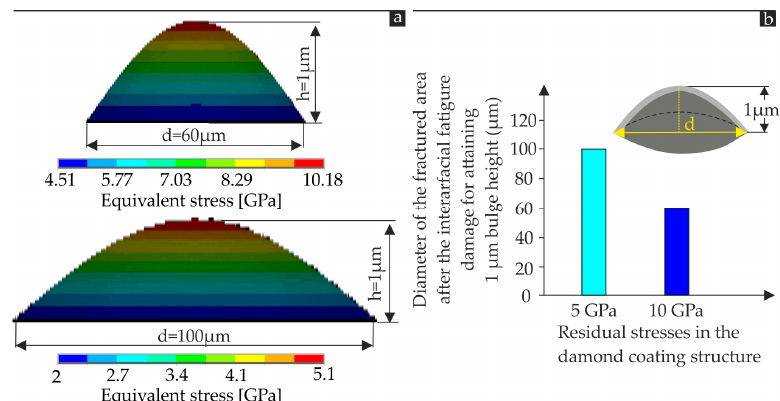
Figure 11. ( a ) Characteristic diamond coating cases for investigating the effect of the amount of their residual stresses on the occurring dimensions of the film bulges; ( b ) the occurring diameter of the fractured area of the investigated coating cases in order to attain 1 μ m bulge height.